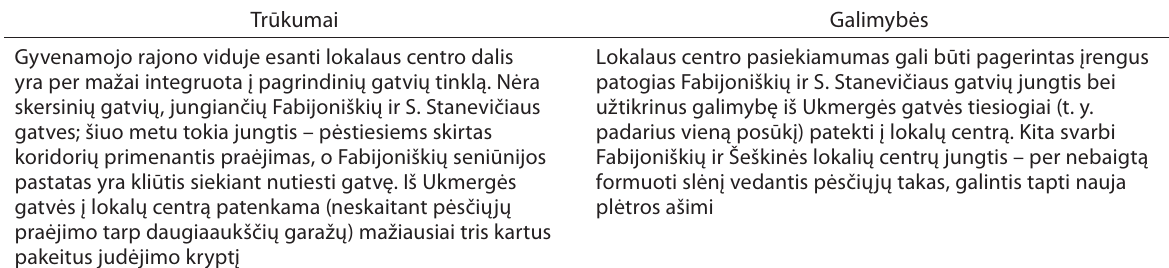
Table 3. Weaknesses and opportunities of the formation of street network in the local centre of fabijoniškės Trūkumai Galimybės